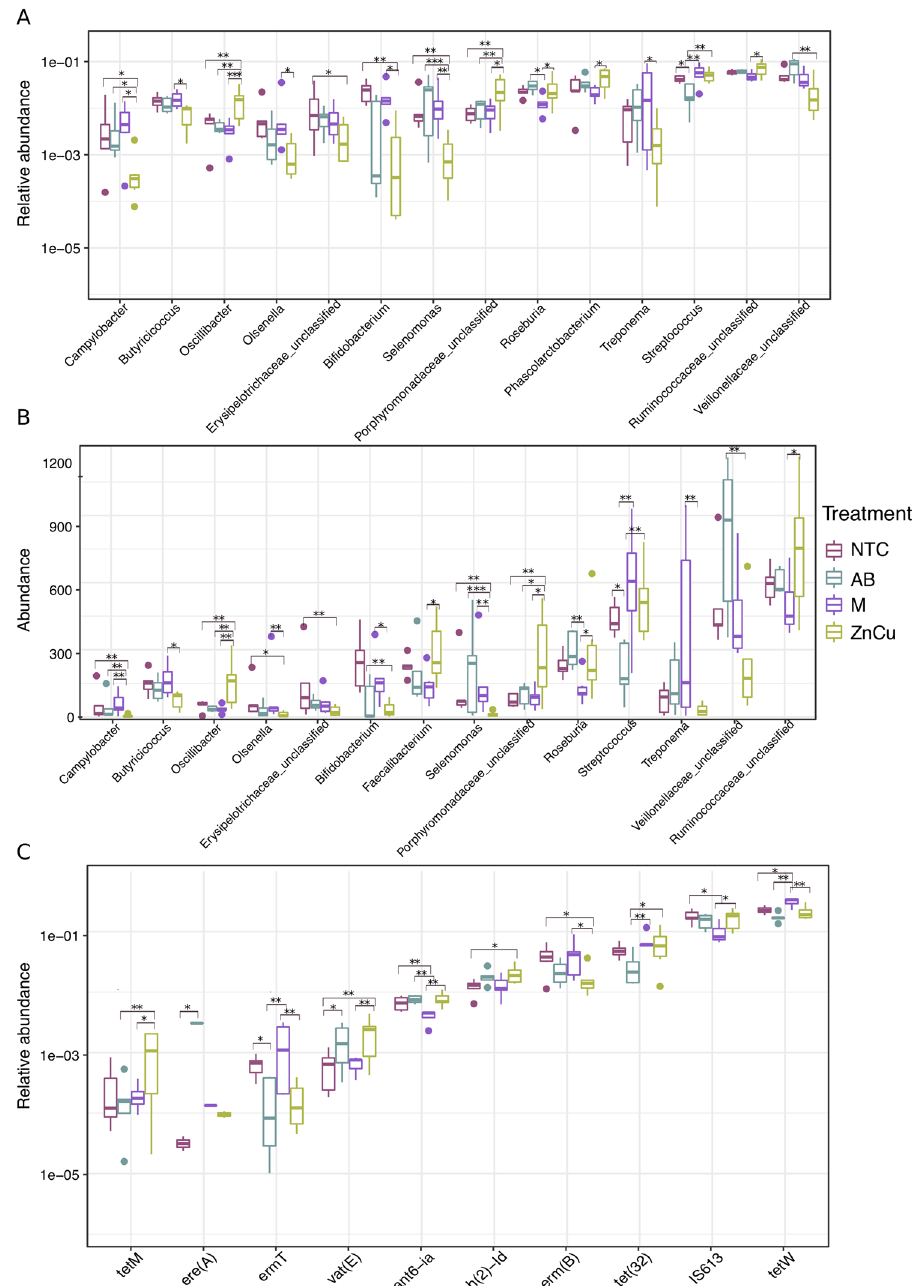
Figure 2. Boxplots showing the most abundant genera, ARGs and MGEs with statistically significant differences between treatment groups labeled on right. NTC non-treatment control, AB carbadox (antibiotic), M mushroom powder, ZnCu zinc oxide and copper sulfate. The asterisks “*”, “**” and “***” denote statistical significance levels at p < 0.05, p < 0.01 and p < 0.001, respectively. ( A ) Most abundant genera in TSS normalized OTUs (n = 14), ( B ) most abundant genera in rarefied and subsampled OTUs (n = 14), ( C ) most abundant genes related to resistance and transfer (n = 10). See Supplementary Fig. S3A, B and C for all differentially abundant genera and ARGs and MGEs and Supplementary Tables S2, S3 and S4 for fold changes of the differently abundant genera and ARGs and